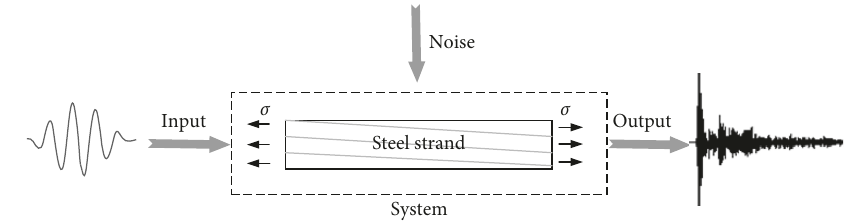
Figure 1: System of guided wave